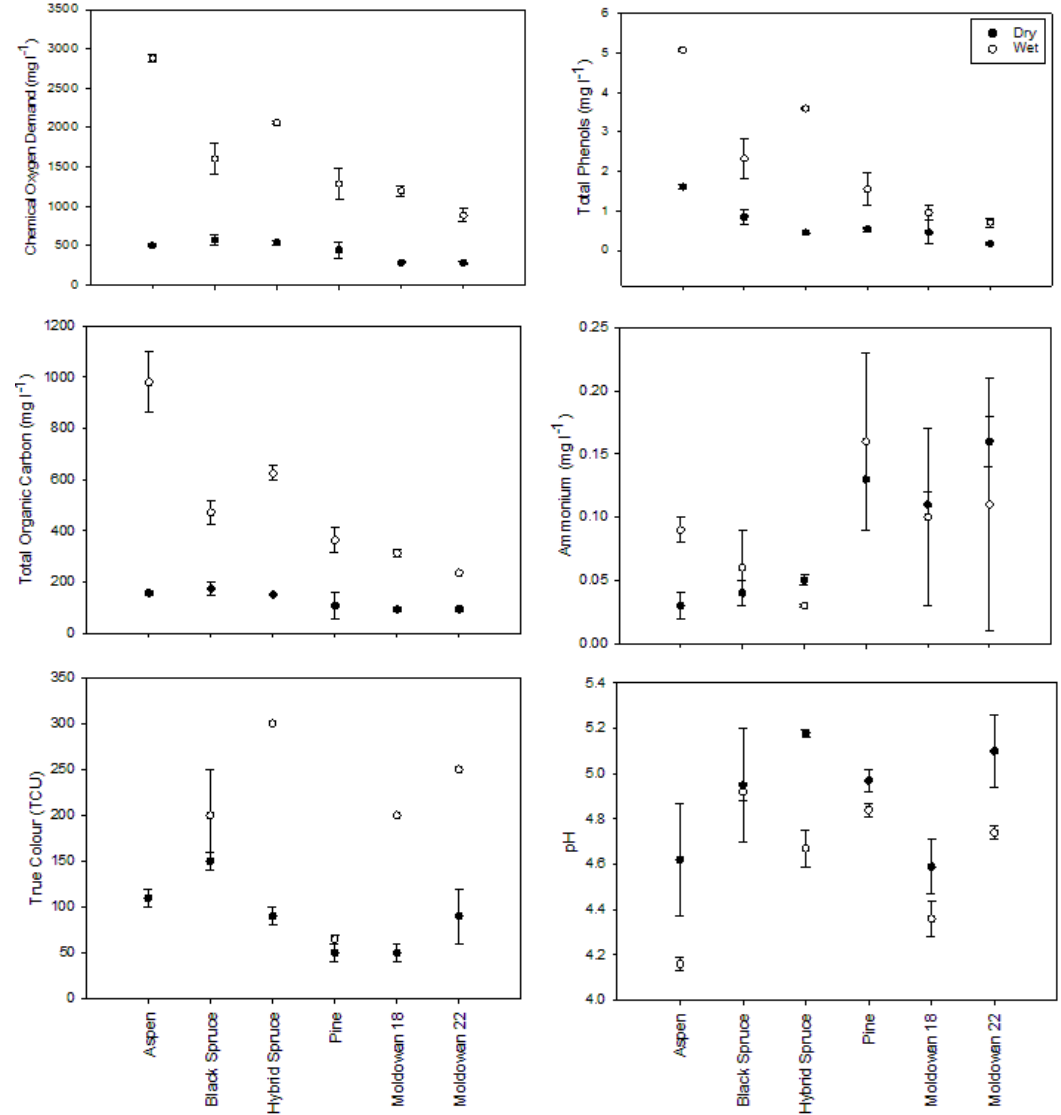
Figure 5. Rainfall simulation leachate chemical conditions for dry and wet wood chips. Bars represent standard error ( n = 2).